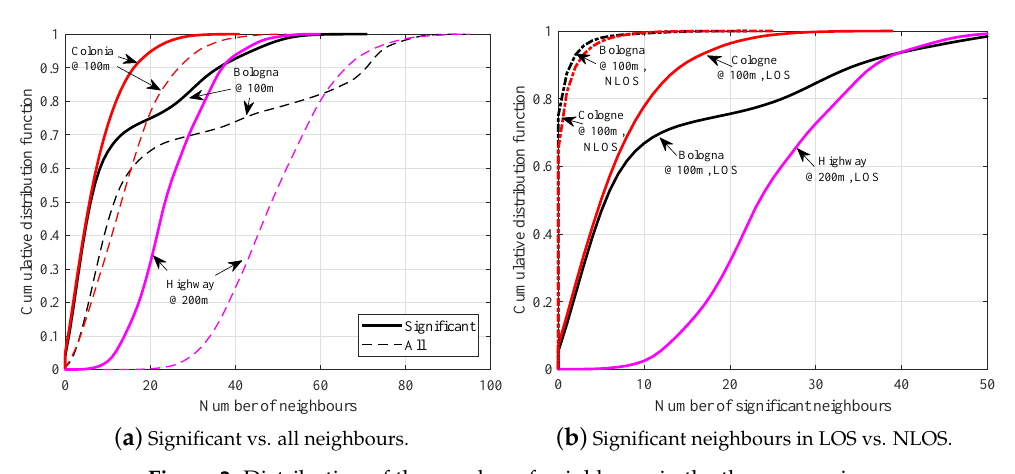
Figure 2. Distribution of the number of neighbours in the three